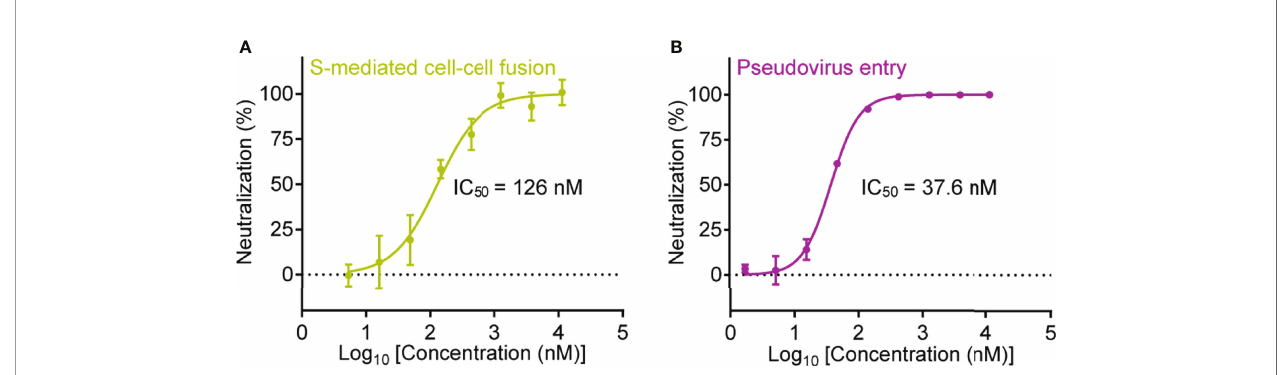
FIGURE 2 | Quantitative analysis of the inhibitory activity of Nb-007. (A) Inhibition of the SARS-CoV-2 S-protein-mediated cell-cell fusion with 3-fold serial dilutions of Nb-007 at the indicated concentrations. Error bar stands for the mean ± SD from triplicate experiments. (B) Inhibition of the SARS-CoV-2 pseudovirus entry with 3- fold gradient dilutions of Nb-007 at the indicated concentrations. Error bar shows the mean ± SD